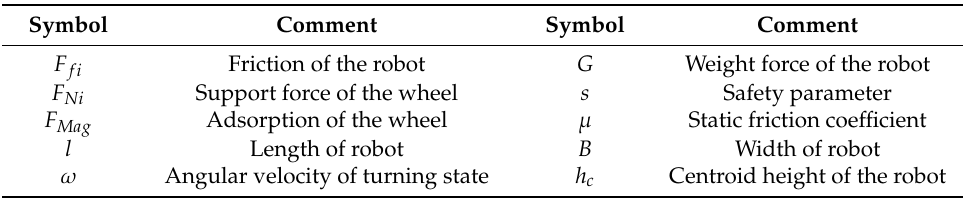
Table 3. Parameters in the mechanical